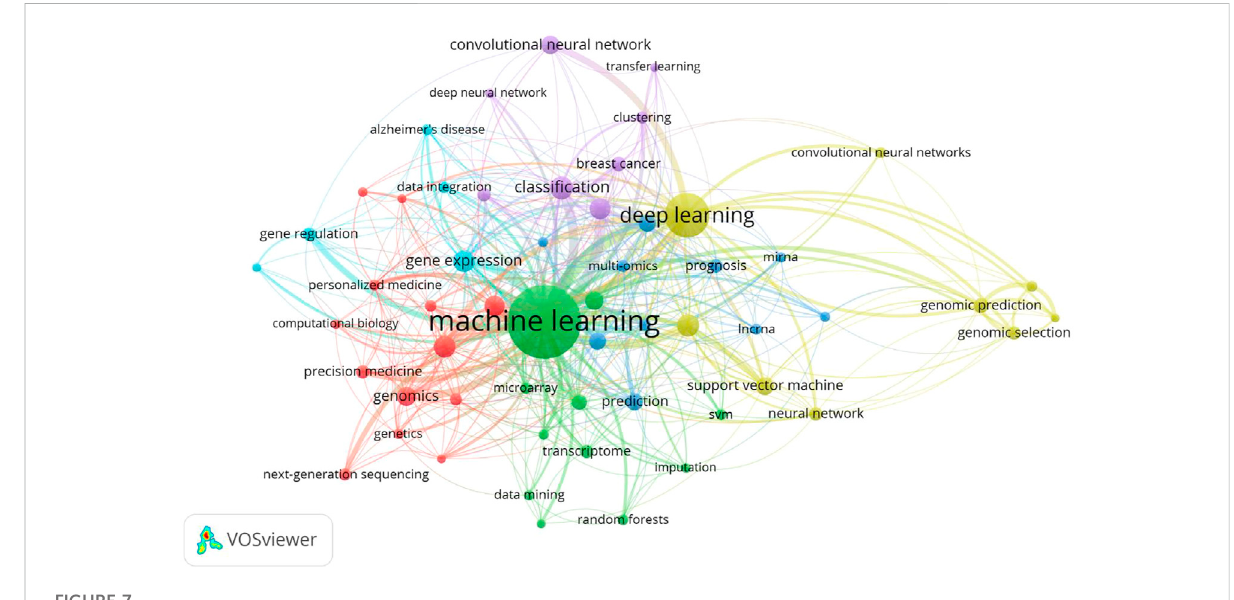
FIGURE 7 Network map of keywords is divided into 6 clusters.